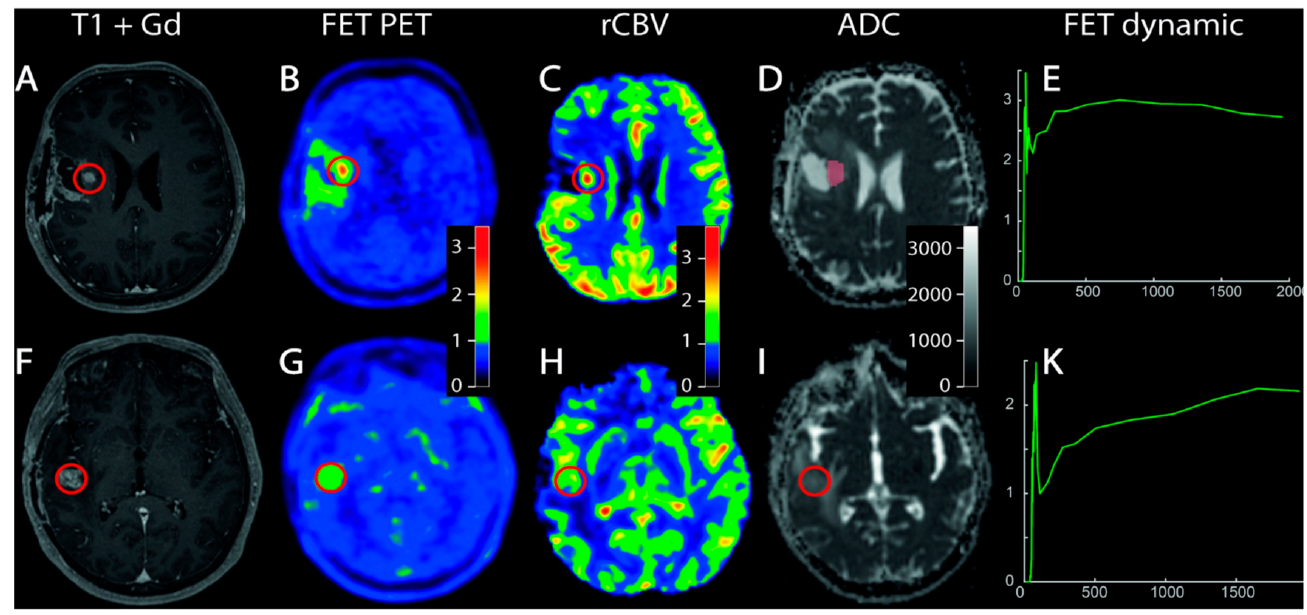
Figure 3. The increased uptake and early time to peak at [ 18 F]FET PET/MRI allowed discriminating of tumour tissue in a patient with operated and irradiated anaplastic astrocytoma and a suspicious contrast-enhancing lesion appeared at MRI during follow-up ( A – E ). No significant uptake and late time to peak was observed in an area of contrast-enhancement at MRI in a patient with radio-chemo- treated glioblastoma, suggesting radiation necrosis ( F – K ). Reprinted/adapted with permission from Ref. [21]. Copyright © 2018 Elsevier B.V.